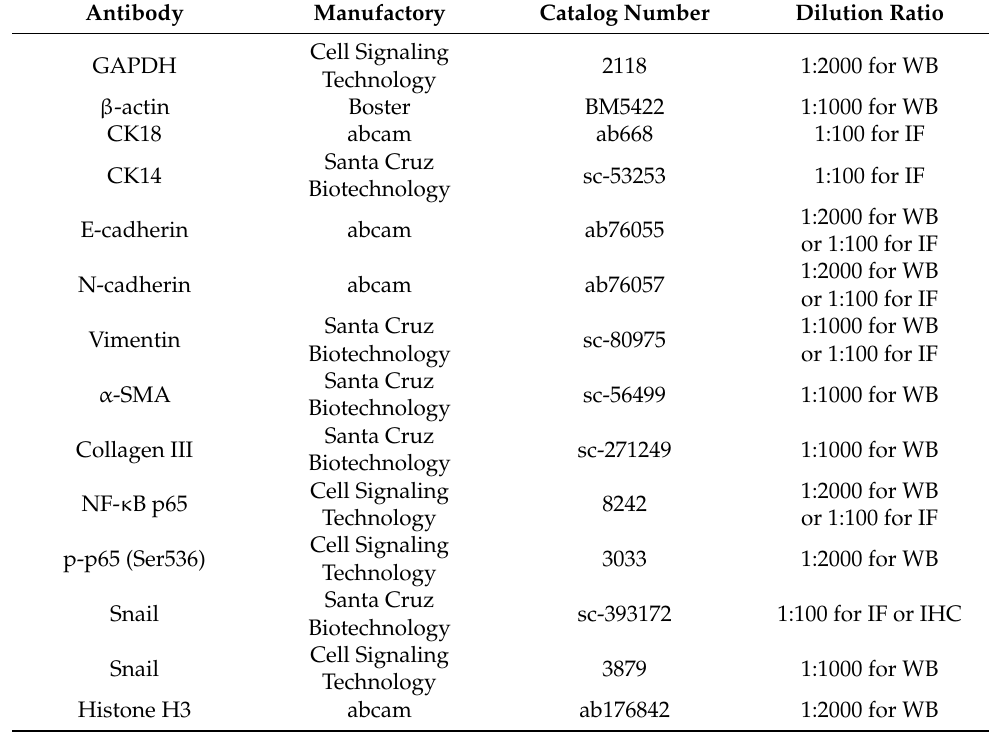
Table A2. Details of primary